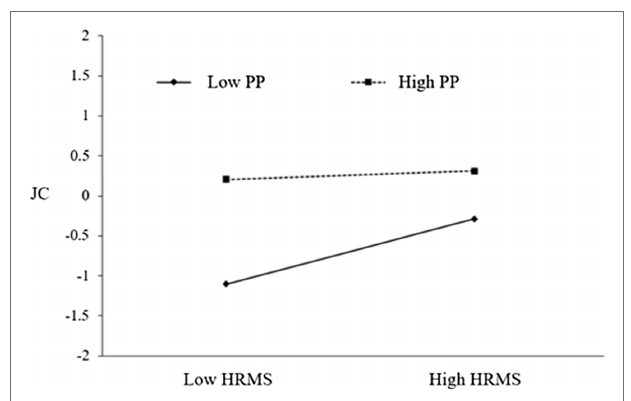
FIGURE 2 | The moderating role of proactive personality in the influence of HRMS on